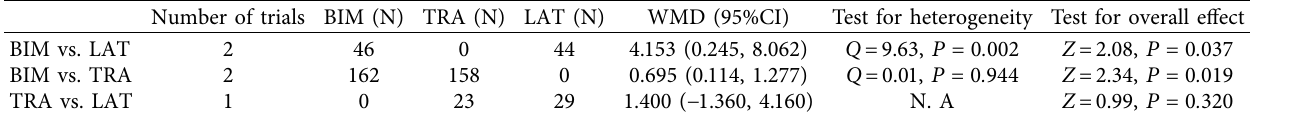
Table 8: Efficacy of PGAs in LNRs.